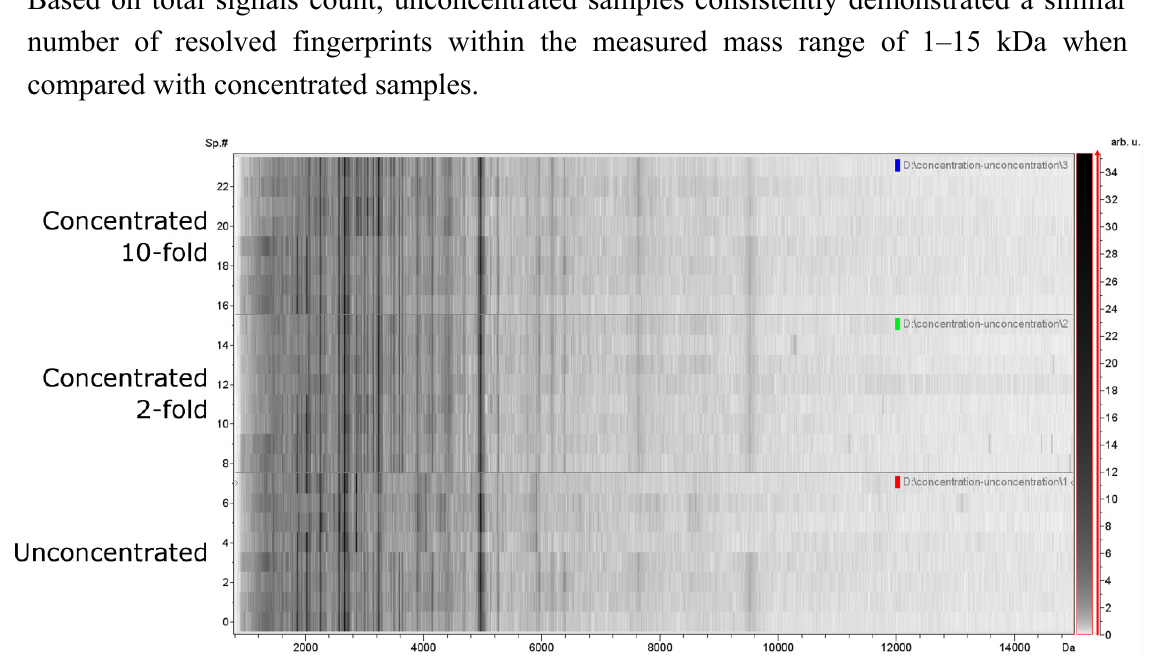
Figure 2. Protein profiles obtained with concentrated and unconcentrated samples. X -axis, the calculated molecular mass ( m / z values); Y -axis, relative intensity of specific